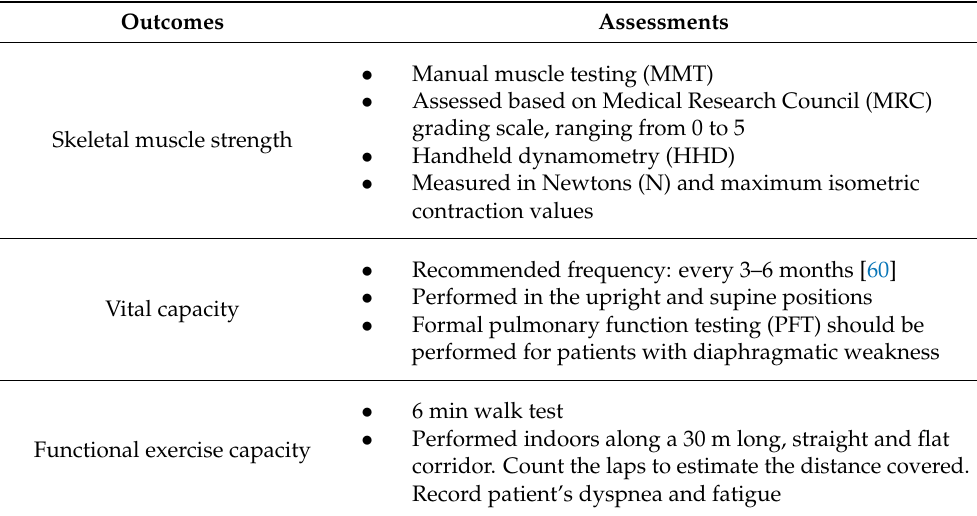
Table 3. Assessment tests on PD disease progression